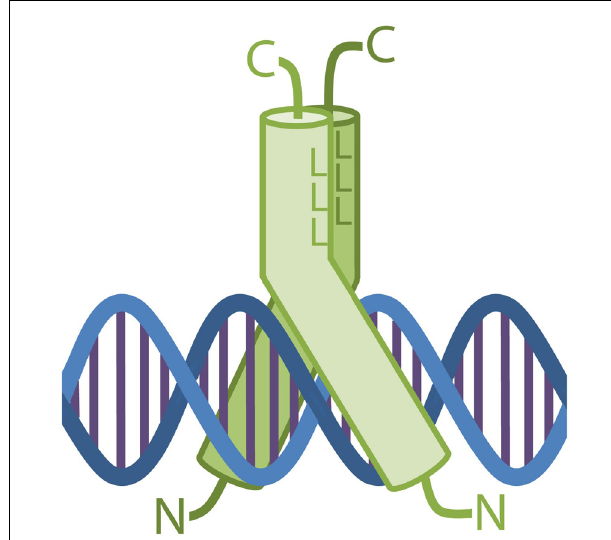
FIGURE 2 | Schematic drawing of a bZIP dimer bound to the DNA. The two proteins form aY-shape structure which embraces a perpendicularly disposed DNA molecule.The major groove is contacted by both bZIPs via their DNA-binding domains. L represents the leucines forming the interface in the bZIP